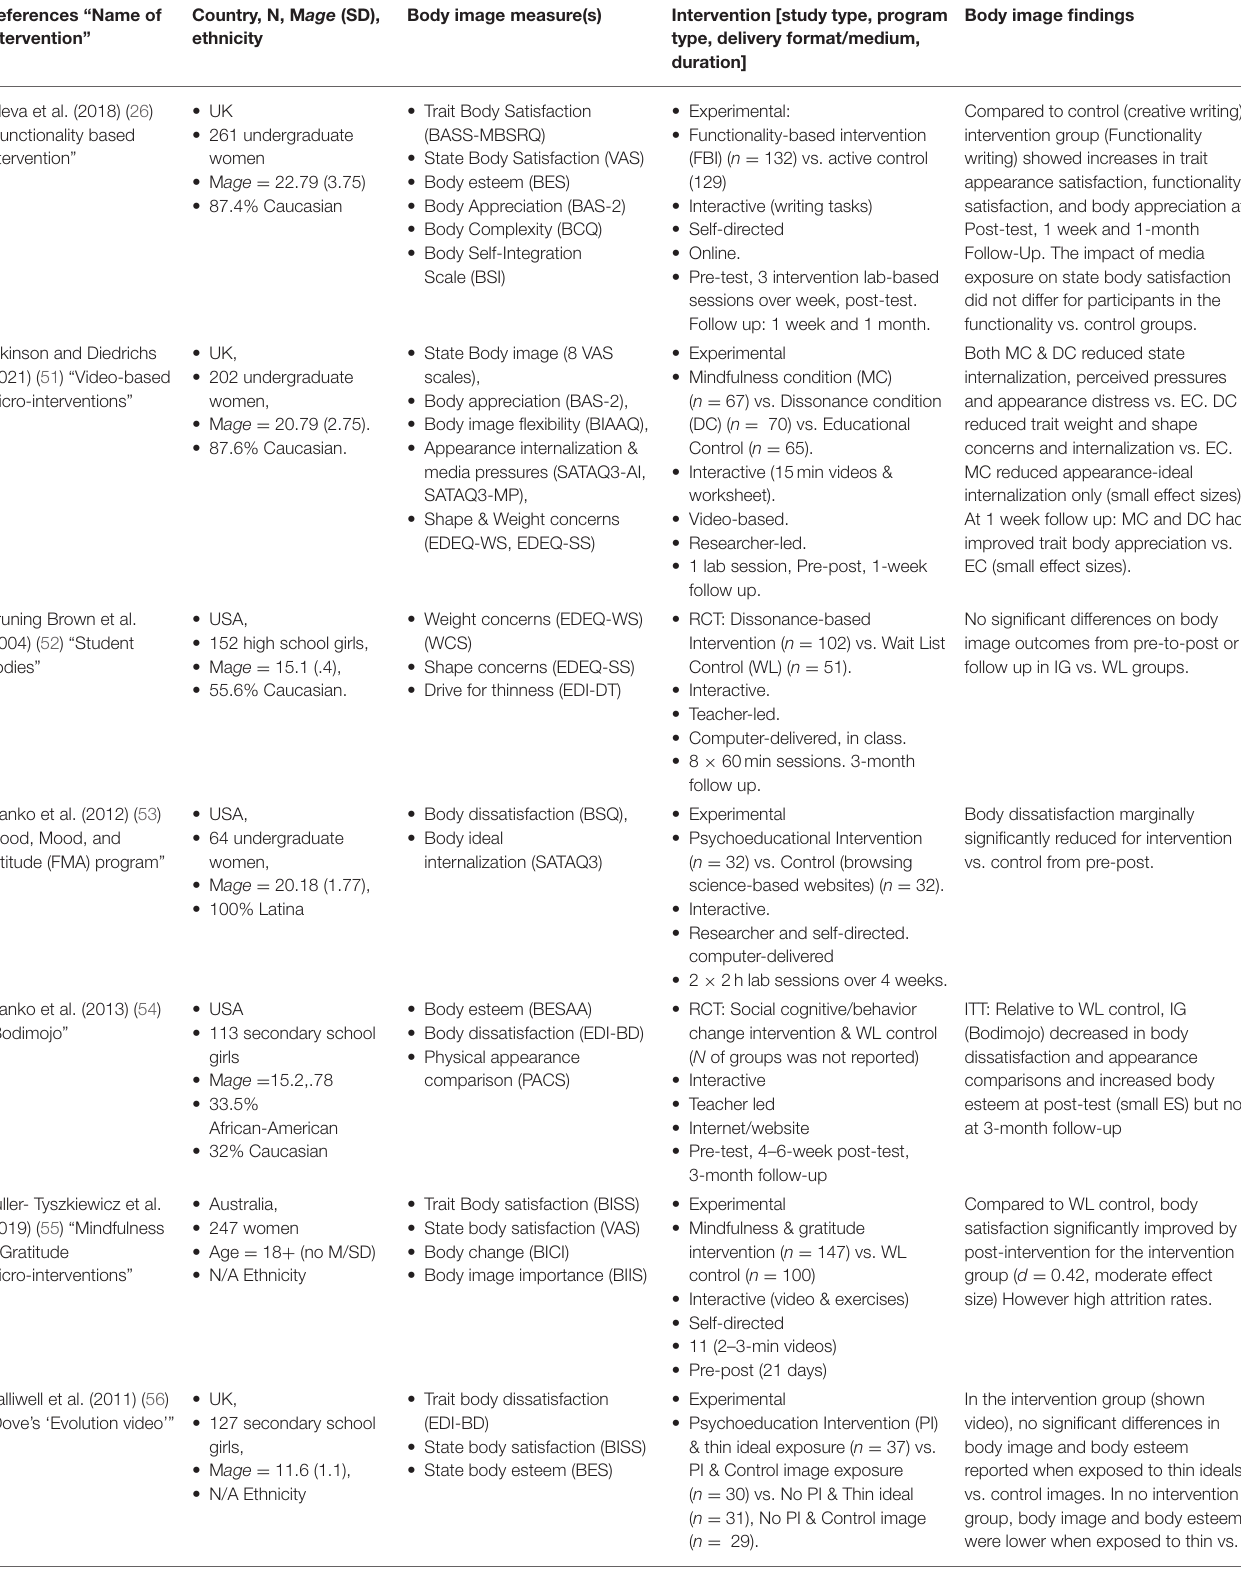
TABLE 1 | Characteristics of studies included in systematic